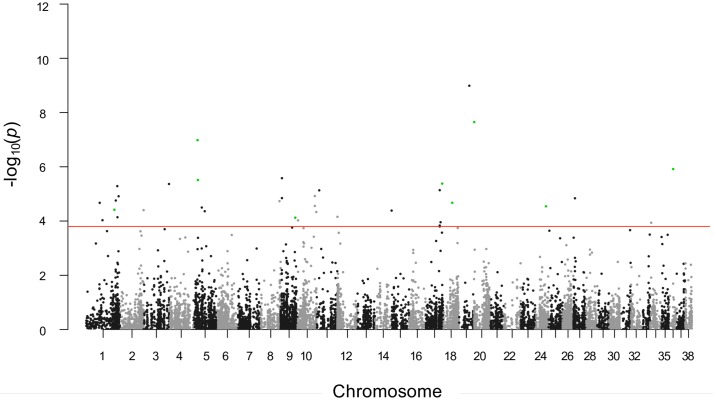
Manhattan plot of SNVs significantly associated with B-cell lymphomas.Manhattan plot of case-control association raw p-values on B-cell lymphomas. Horizontal red line: threshold of significance 0.05 (BH adjusted p-value); green dots: significant novel SNVs.